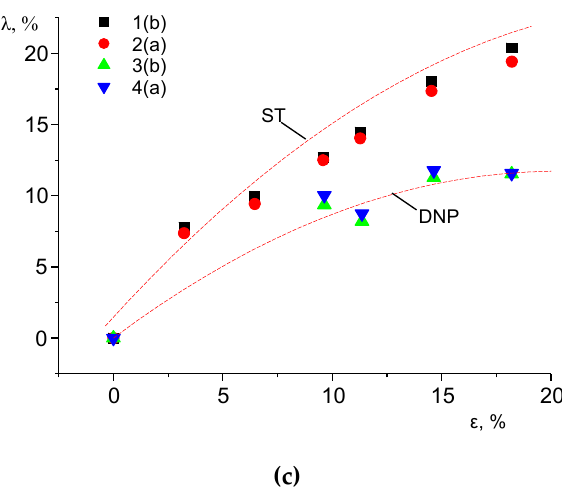
Figure 8. Distribution of hardness on surface layers of steel 12Kh17 depending on residual strain: ( a ) Average value throughout the gauge length of the specimen; ( b ) average value on the central rectangle (F imp = 120 kN); ( c ) values of λ (%) after ST (1,2) and DNP (3,4).